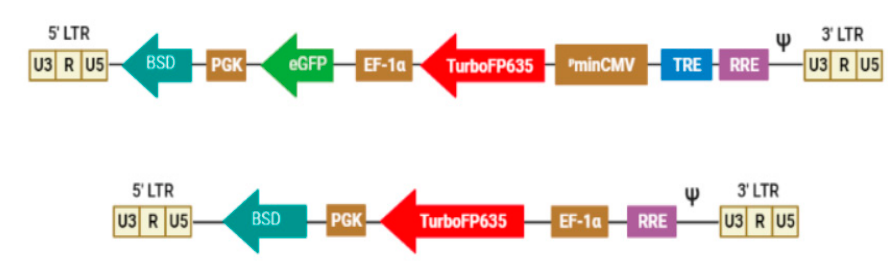
Figure A1. Stable cell lines constructed by lentiviral vector: A1: CV-1-pTet-TurboFP635-EF-1a-Egfp cell line. A2: CV-1-EF-1a-TurboFP635 cell line .